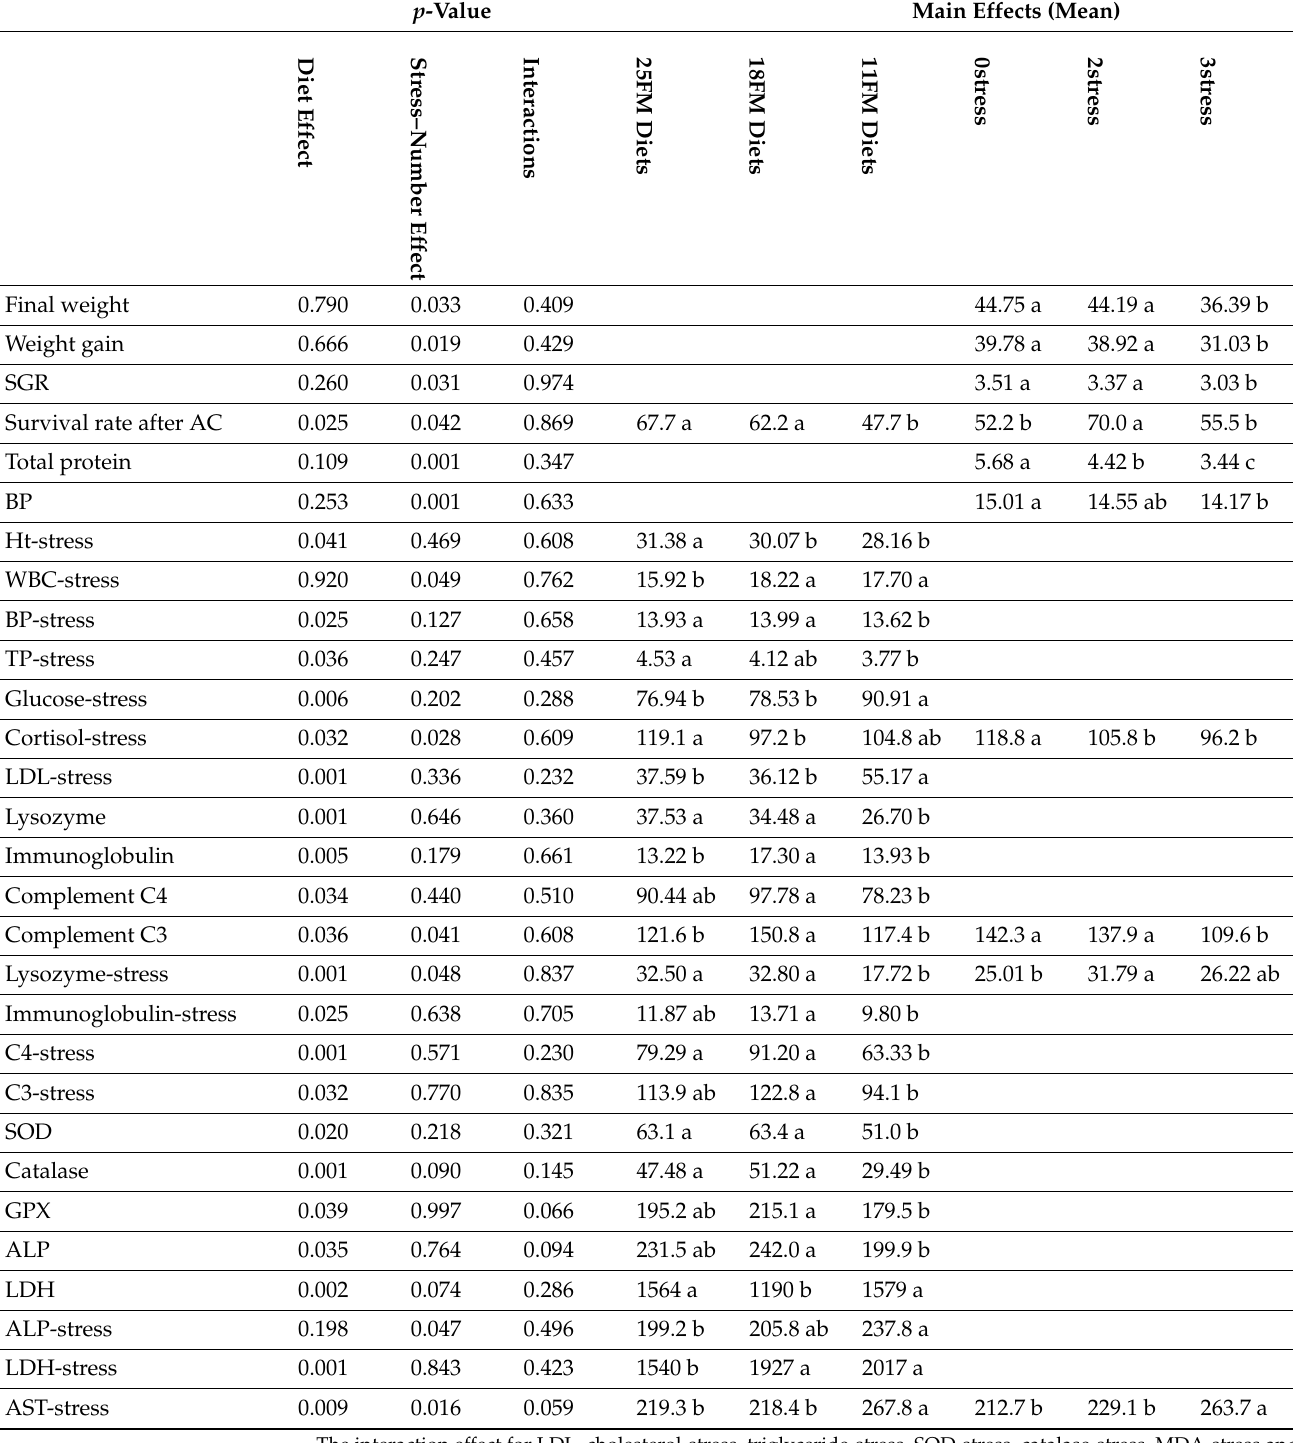
Table 4. The results of two-way ANOVA analysis with SPSS for measured factors. When the interaction was not significant, we compared the “Diet Effect” via Independent Samples t -Test and “Stress-number Effect” via Duncan’s new multiple range test for the case these effects were significant ( p < 0.05). The non-significant parameters were not reported. The letters a, b and c indicate significant differences among treatments exposed to different stress